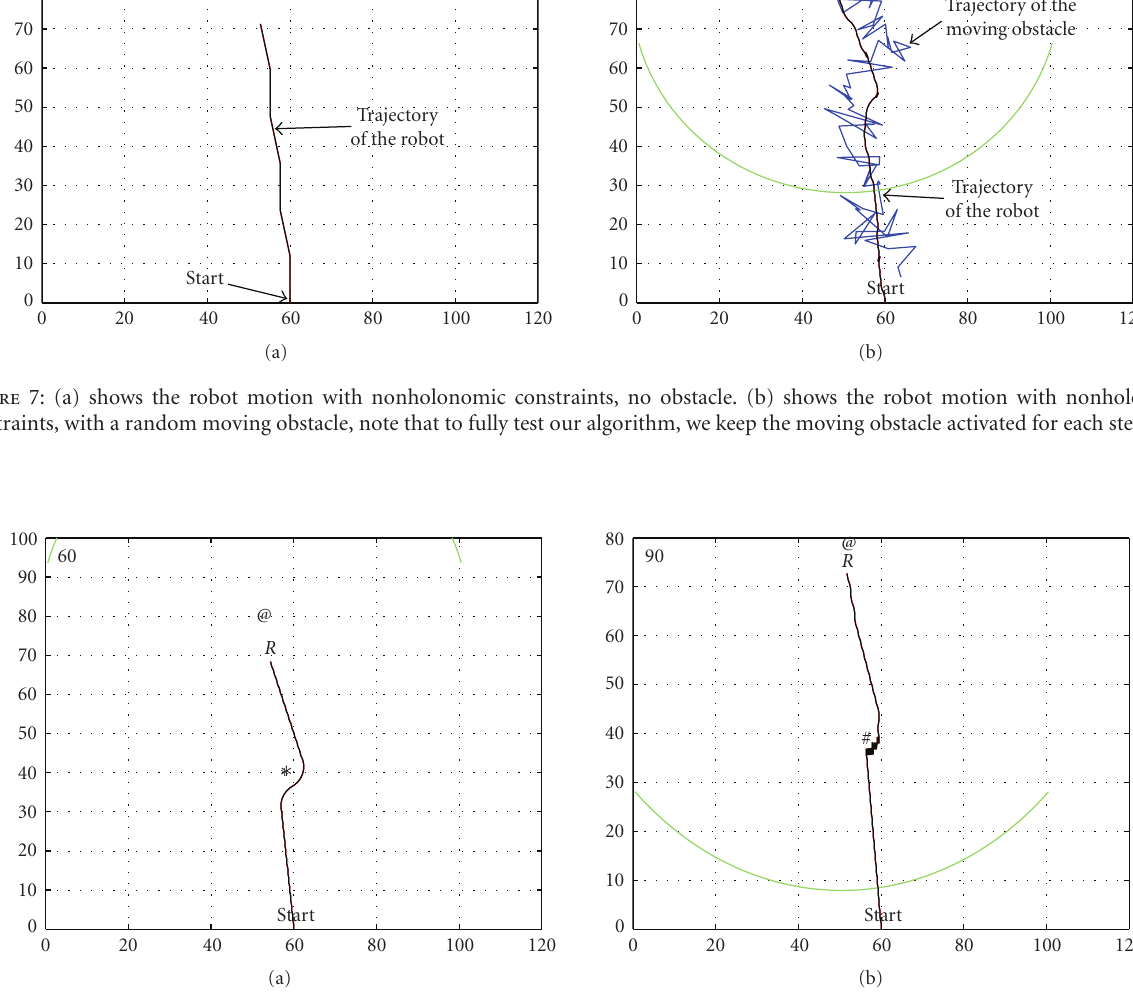
Figure 8: (a) shows the robot motion with nonholonomic constraints, with a static obstacle at (55,40), (b) shows the robot motion with nonholonomic constraints, with a moving obstacle moving around